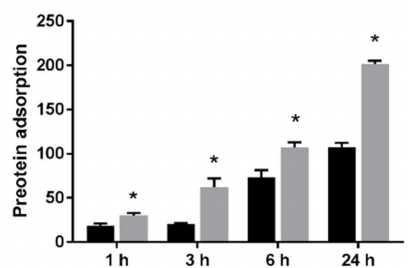
Figure 4. The e ff ect of UV treatment on the surface of NANOZR on the adhesion of the material surface of BSA is shown. Evaluation time is 1 h, 3 h, 6 h and 24 h after incubation. BSA adhesion was significantly higher on the NANOZR surface of the test group compared to the control group at all counting times. (Gray bar—untreated surface, black bar—UV-treated surface). (*: p < 0.05)